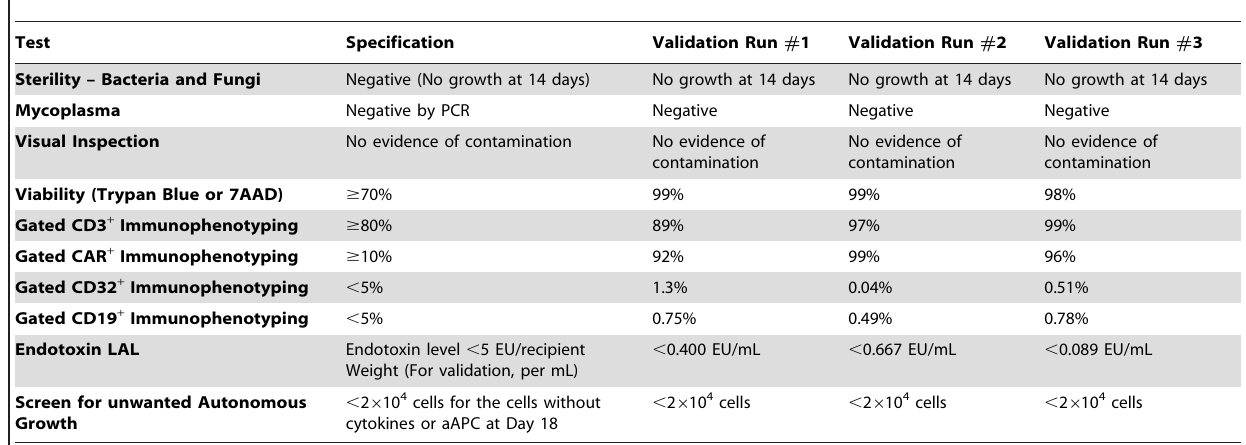
Table 1. Acceptance criteria for releasing electroporated and popagated T